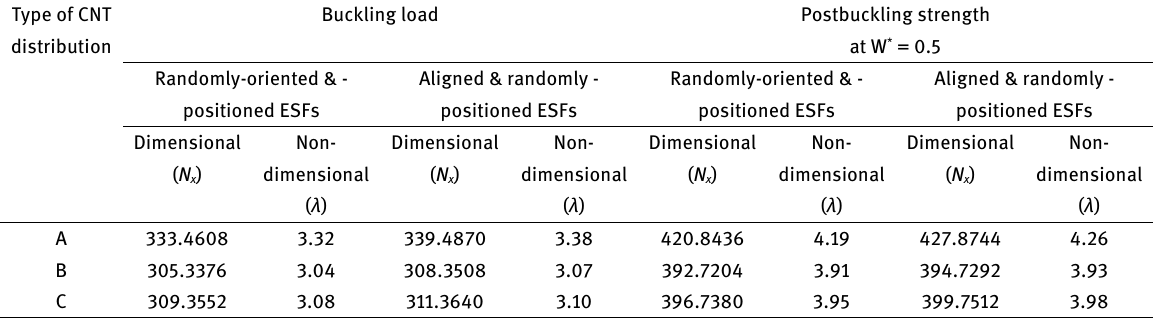
Table 7: Effect of ESF-alignment on the buckling load and postbuckling strength of SSSS FG-ESF-reinforced Mg nanocomposite plate. Type of CNT